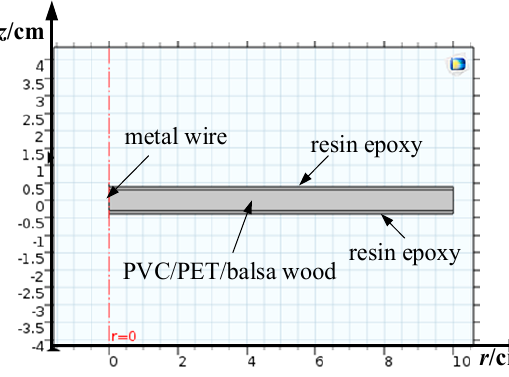
( c ) Figure 5. Inside damage of samples: ( a ) PVC; ( b ) PET; ( c ) balsa wood. Table 2. Damage radius (cm). Current Peak Value (kA)